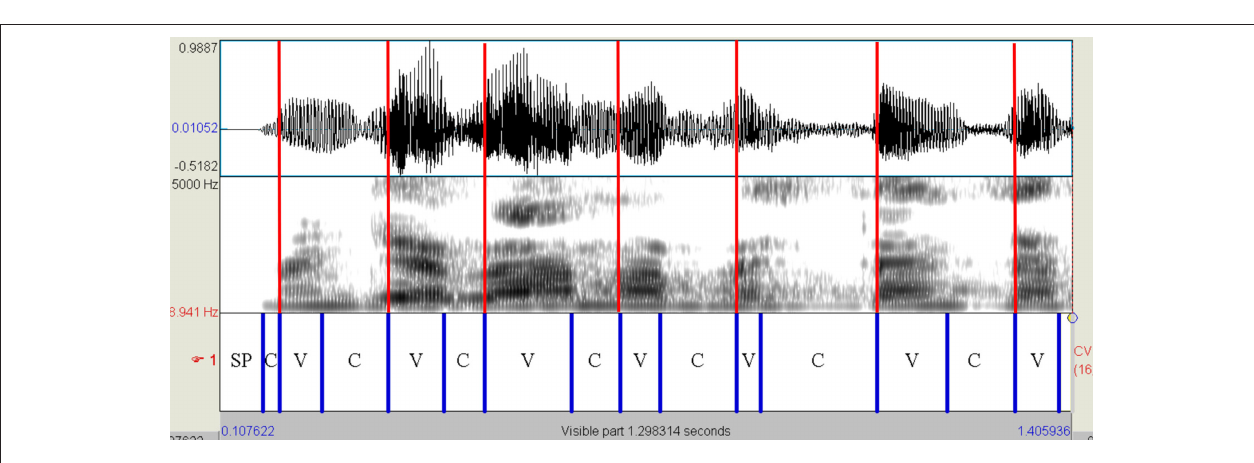
Frontiers in Psychology |